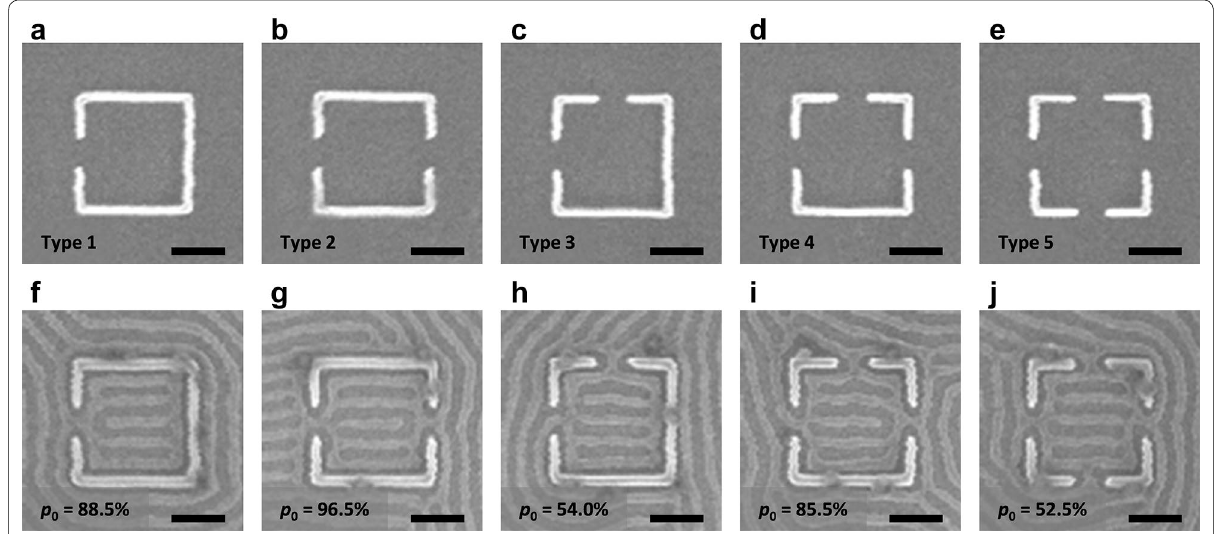
Fig. 3 SEM images of square confinement with openings and the resulting block copolymer patterns. Ratio of 0 state (denoted by p 0 ) for each type was measured in a large array. Binary states were determined based on the number of horizontal and vertical openings. a , f Square confinement with one horizontal opening. Preferential horizontal alignment (0 state) was observed. b , g Square confinement with two horizontal openings on non‑adjacent sides. Stronger preferential horizontal alignment was observed. c , h Square confinement with two openings on adjacent sides. Alignment in both directions was observed with equal probability. d , i Square confinement with three openings. Preferential horizontal alignment was observed. e , j Square confinement with four openings. Alignment in both directions was observed with equal probability. These results demonstrate the templating effect from openings. Scale bars, 200